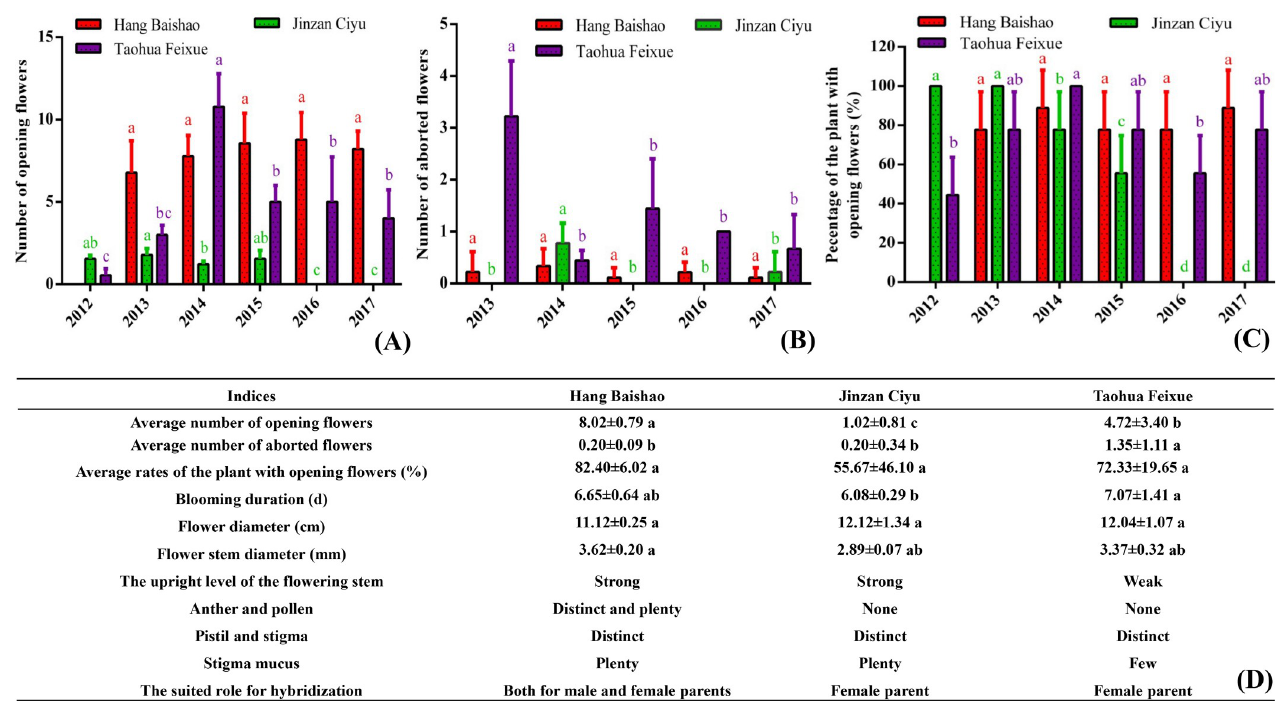
Fig 5. Observation and comparison of the flowering performance of three cultivars over six years. Differences were compared among different years for each cultivar in Fig 5A, 5B and 5C and compared among different cultivars for each index in Fig 5D. Values represent the averages from three replicates ± standard